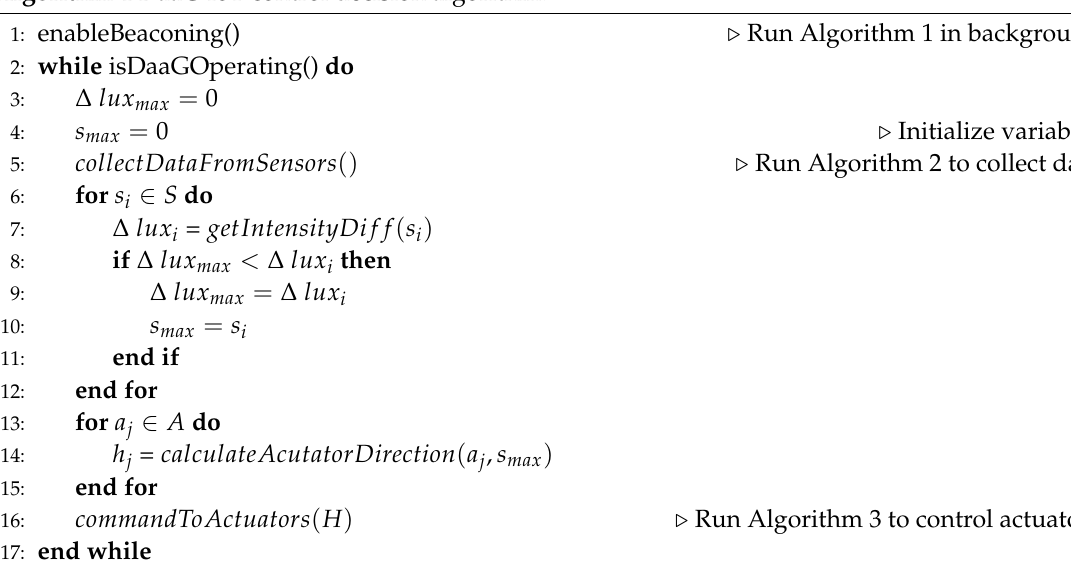
Algorithm 4 DaaG IoT control decision